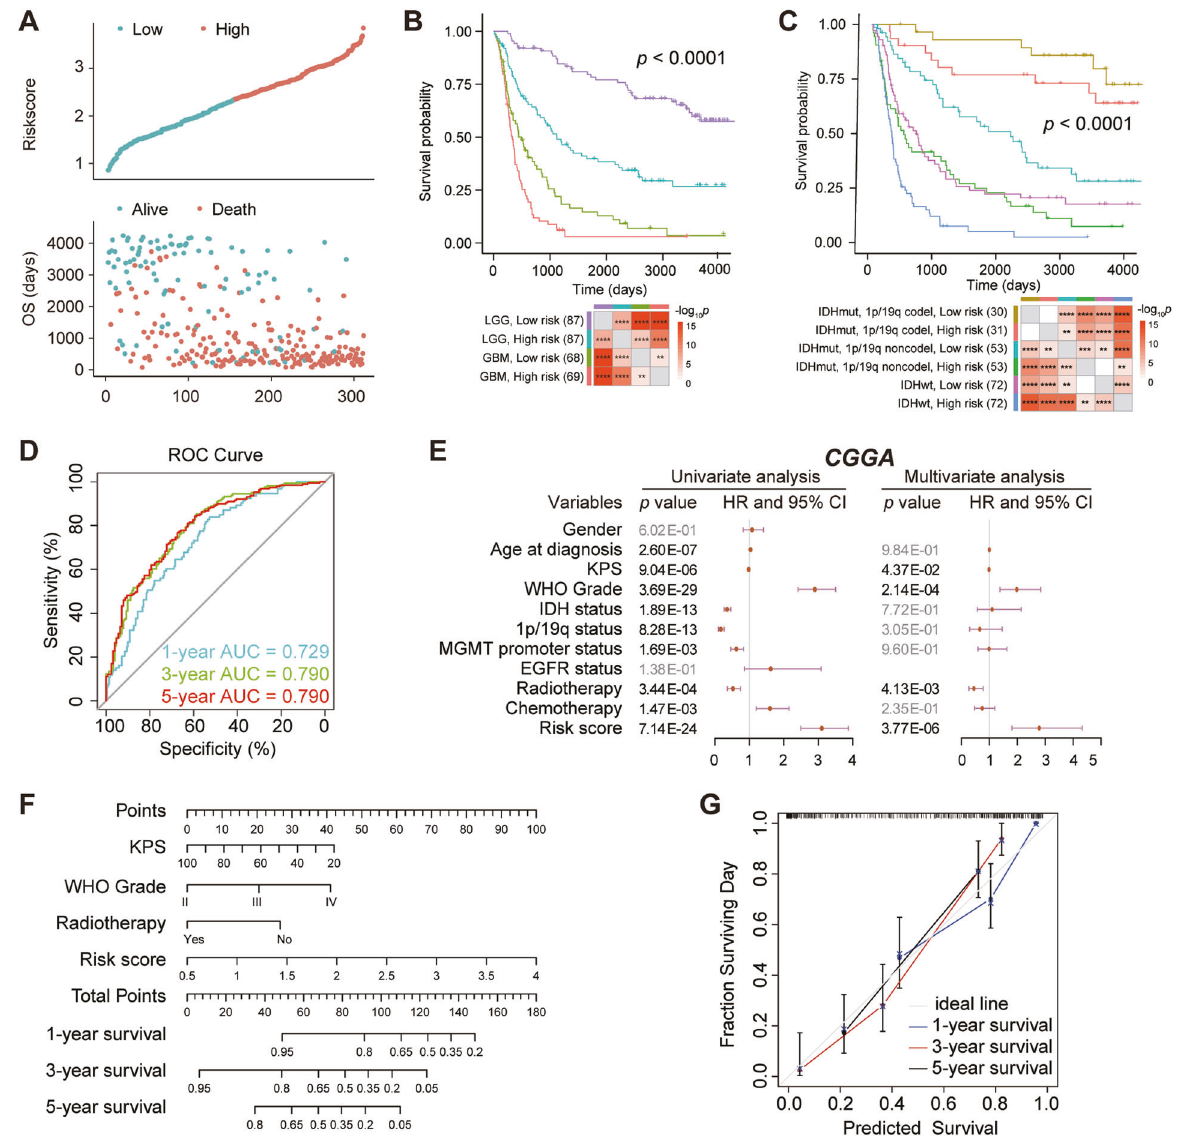
Fig. 4 The prognostic value of the fi ve-gene prognostic signature in CGGA dataset. A The risk score distribution (top) and survival status distribution (bottom) for glioma patients. B Kaplan – Meier survival curves for patients with glioma, classi fi ed into four groups based on grade and risk scores. C Kaplan – Meier survival curves for patients with glioma, classi fi ed by molecular pathological characteristic and risk scores. D ROC curves veri fi ed the prognostic performance of the risk score. E Univariate and multivariate Cox regression analyses of the association between clinic pathological factors and OS of patients. F Construction of a nomogram for survival prediction. G The calibration curve for the nomogram model. Three colored lines (blue, red and black) represent the performance of the nomogram. A closer fi t to the diagonal gray line indicates a better estimation. **** p < 0.0001; *** p < 0.001; ** p <